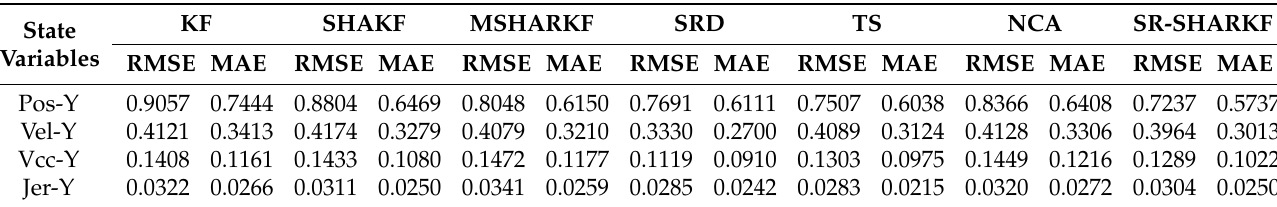
Figure 5. Dynamic parameter error in the Y-axis direction. ( a ) Position error. ( b ) Velocity error. ( c ) Acceleration error. ( d ) Jerk error. Table 2. Dynamic parameter error evaluation in the Y-axis